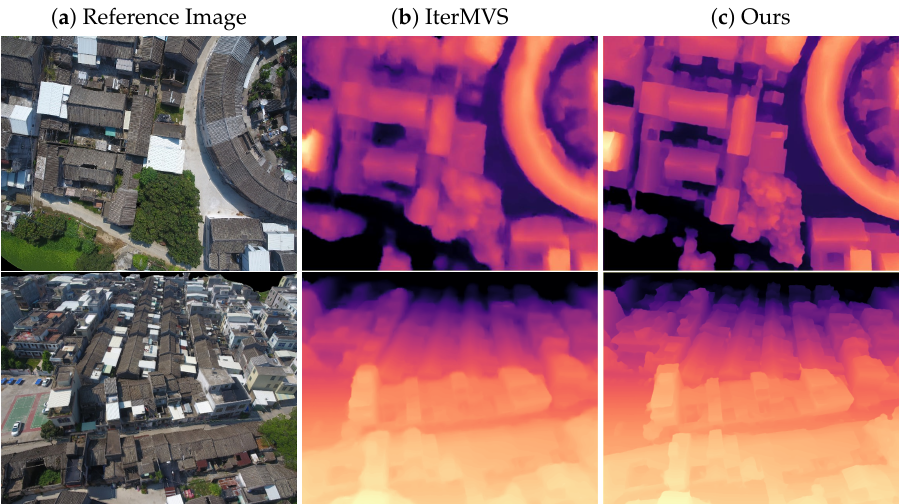
Figure 8. Comparison of depth estimation on the BlendedMVS validation set. Our depth map is significantly finer than IterMVS [24] in terms of target edge effect and depth